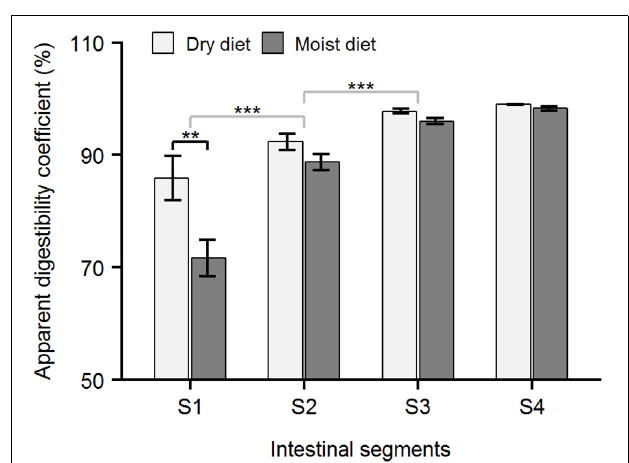
FIGURE 7 | Apparent digestibility coefficient (ADC) of carbohydrate in ballan wrasse intestine. The figure shows the ADC (%) of carbohydrate in the 4 intestinal segments (S1–S4) of ballan wrasse fed with dry or moist diets. Asterisk’s ( ∗ ) above horizontal square brackets indicate significant differences (glmmPQL test in R) between treatments (black line) or between adjacent intestinal segments (gray lines). ∗∗∗ p < 0.001, ∗∗ p < 0.01. Data are mean ± SEM, n =